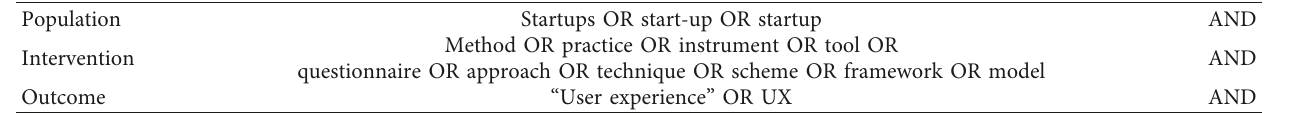
Table 1: Terms used in the search